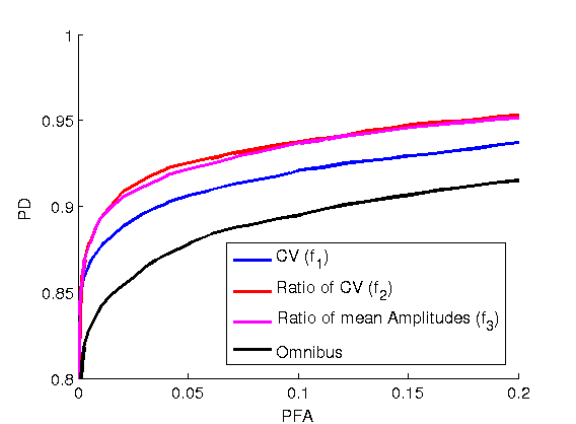
Figure 12. Performances of change detection for ships at the pixel level, on full polarimetric UAVSAR data